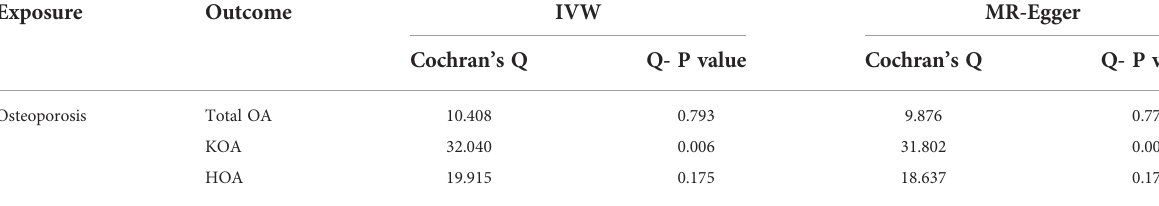
TABLE 3 Heterogeneity tests of osteoporosis causally linked to